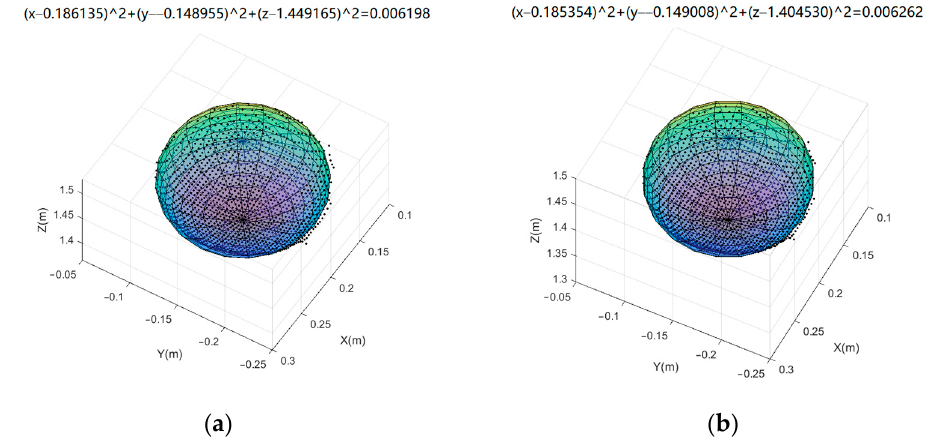
Figure 8. Compensation effect of optimal model on sphere data. ( a ) Before correction; and ( b ) After correction.